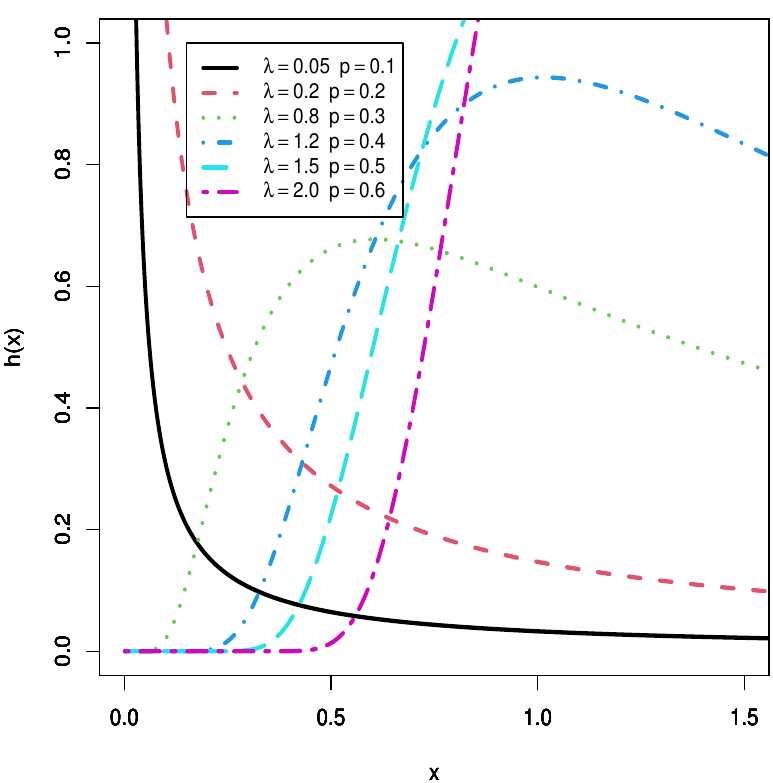
Figure 3. Different shapes of hrf for FB distribution at β = 1.5 and n = 5.